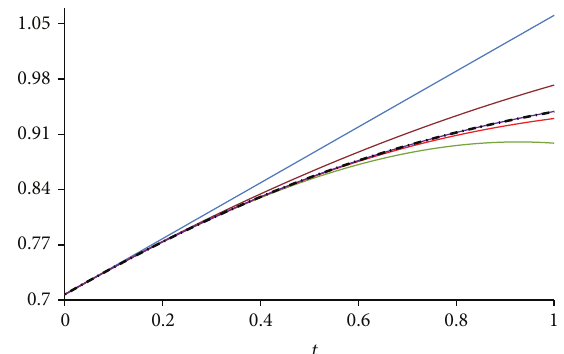
Figure 2: Plots of four iterates of RPS approximation for (49) and (52) when 𝑘 = 2, 3, 4, 10 together with the initial guess approximation and the exact solution; blue: 𝑥 green: 𝑥 3 (𝑡); red: 𝑥 4 (𝑡) ; purple: 𝑥 10 (𝑡); (- ⋅ -): 𝑥